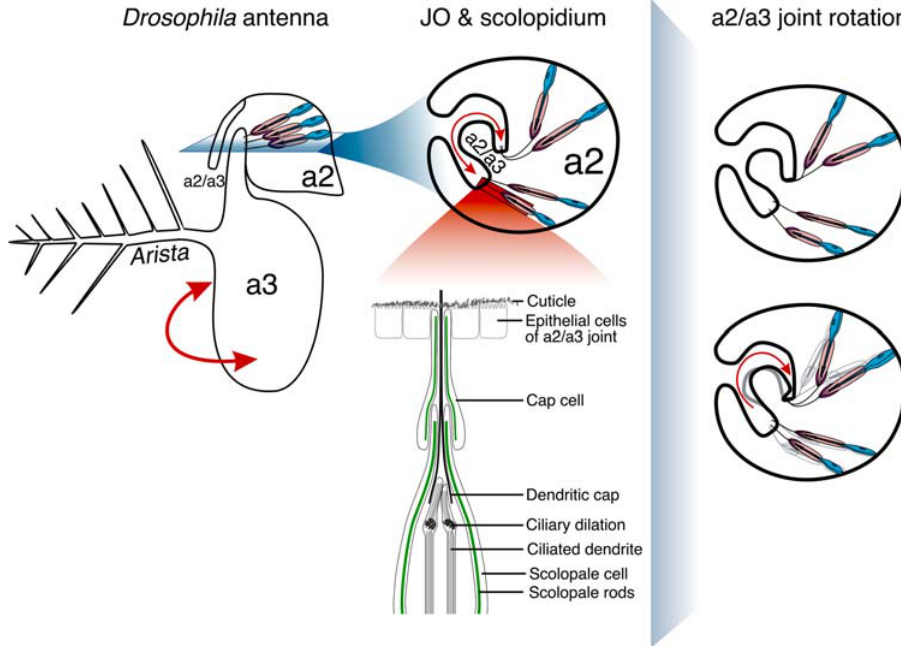
Figure 1. Schematic of the antenna and JO. Drawing not to scale.